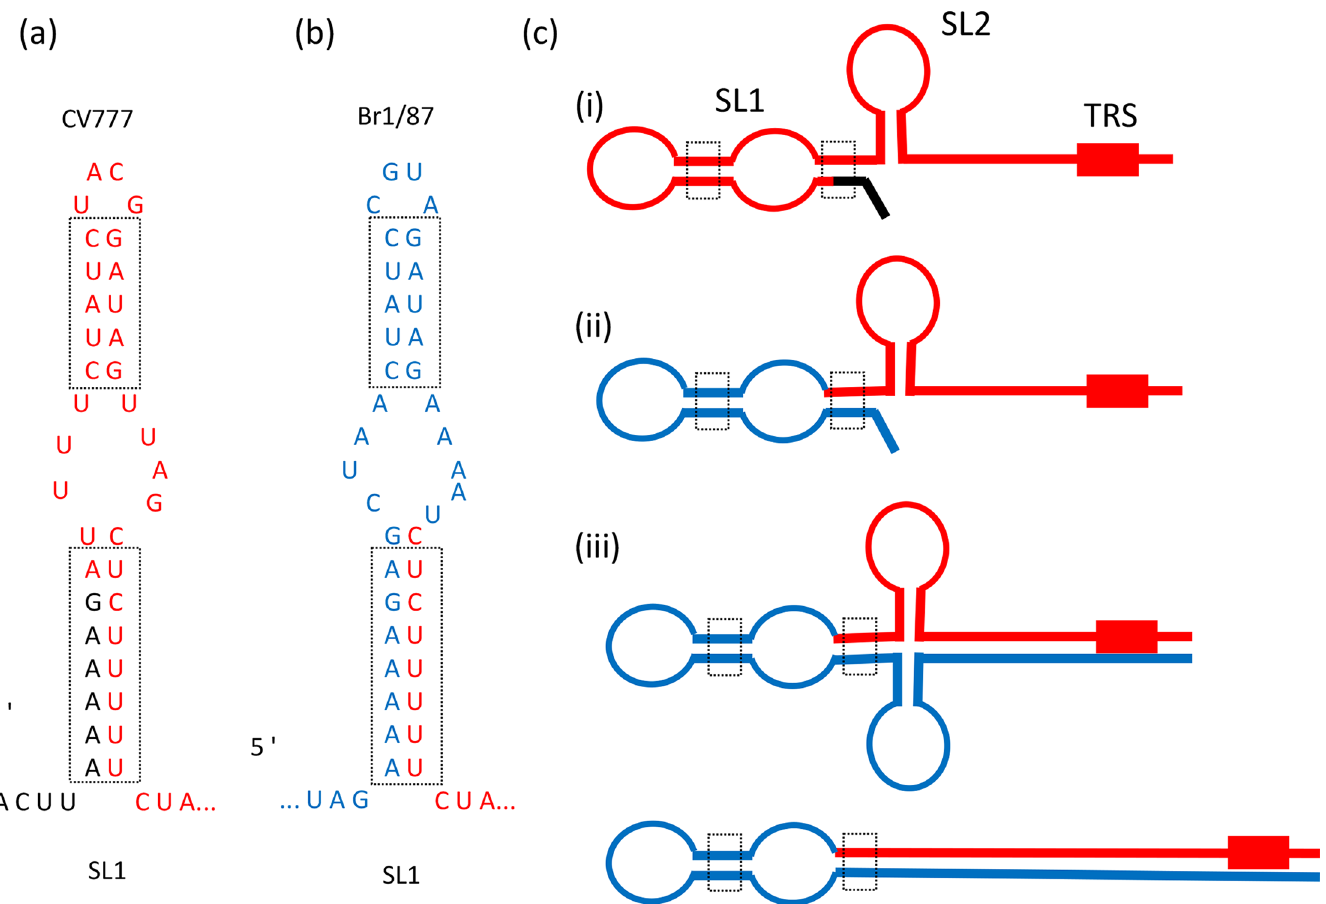
Fig 5. Secondary structure at the 5´-termini of the PEDV RNA genome. Multiple stem-loop (SL) structures have been predicted to be present in the 5´-terminal region of the PEDV genome [21]. The structure, termed SL1, closest to the terminus, in the CV777 reference strain is indicated in panel (a). A similar structure, predicted for the consensus Br1/87 sequence, is shown in panel (b). Note, the sequence marked in blue is the “reverse complement” of the sequence marked in red from panel (a). The conserved stems within SL1 are boxed but the apical loop region is distinct. In panel (c), a comparison of secondary structure predictions derived by M-fold for the CV777 5´-terminal sequence (i) and the consensus Br1/87 sequence (ii), are shown. The structures have the same apical loops as the SL1 structure shown in panels (a) and (b). The extended sequences (in blue), that include self-complementary regions extending beyond the TRS are indicated in panel (c) (iii). The complementary sequences (e.g. the sense and anti-sense SL2 regions) can simply base pair to each other to form an extended stem-loop structure that can be present at the 5´-terminus of the genomic and sub-genomic mRNAs (see also Fig 6).